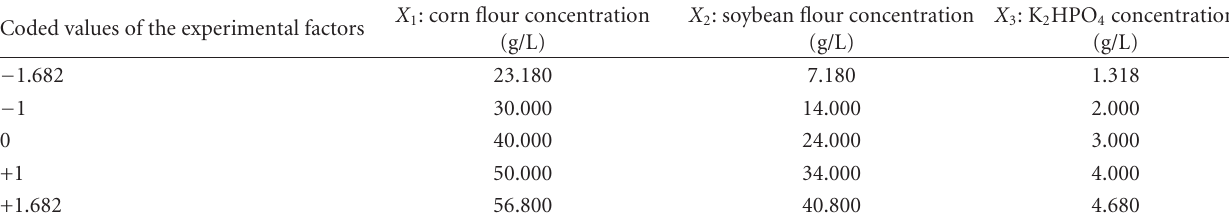
Table 2: Coded values for each factor of the central composite design.